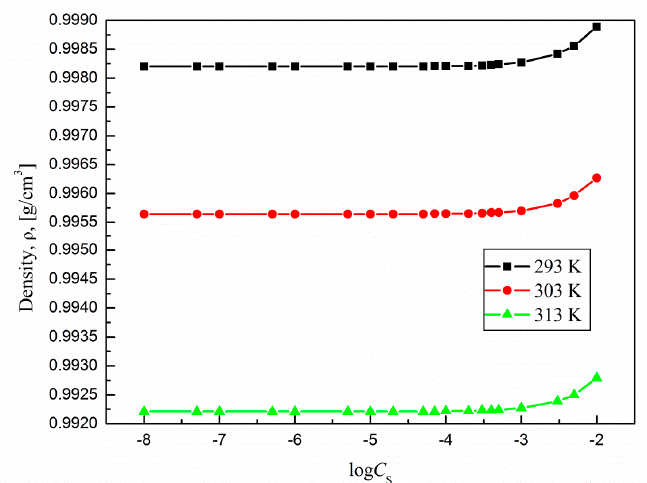
Figure 13. Density ( ρ ) of aqueous solutions of TS-OE12 at 298 K, 303 K and 313 K vs. the logarithm of surfactant concentration (log C S ).